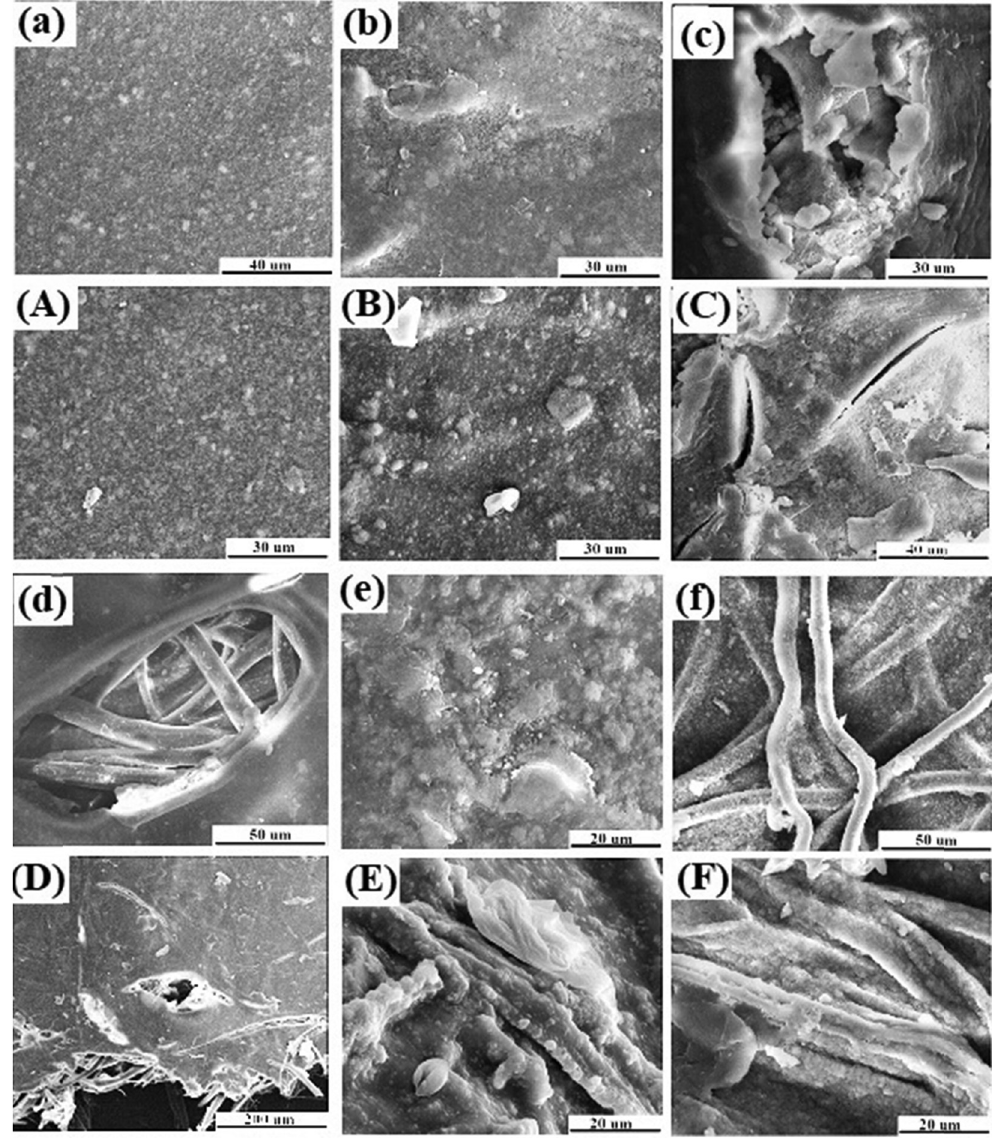
Figure 7: SEM micrographs of composite sca ff olds with di ff erent weight ratios after soaking in SBF: ( a and A ) CS/n - HA ( 6:2 ) , ( b and B ) SF/CS/n - HA ( 1:6:2 ) , ( c and C ) SF/CS/n - HA ( 2:6:2 ) , ( d and D ) SF/CS/n - HA ( 6:6:2 ) , ( e and E ) dissolved SF/CS/n - HA ( 1:6:2 ) , and ( f and F ) un - degummed SF/CS/n - HA ( 1:6:2 ) . ( a – f ) Soaked for 2 weeks, ( A – F ) soaked for 8